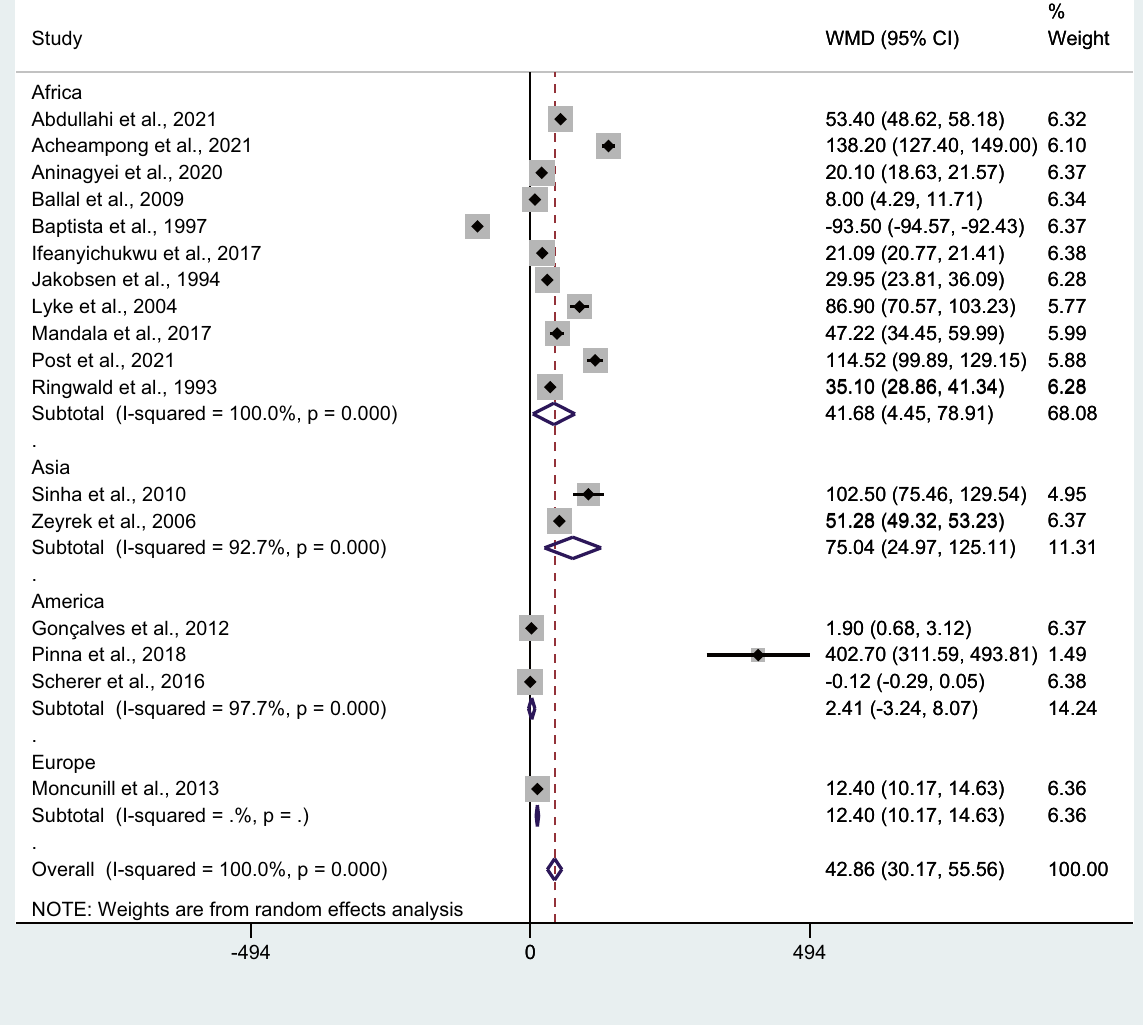
Figure 8. Differences in IL-6 levels between patients with uncomplicated malaria and controls by continents. Abbreviation: WMD, weighted mean difference; CI, confidence interval; black diamond symbol, point estimate; solid line in the middle of the graph at 0, zero effect size; Dashed red line: pooled WMD between the two groups; I 2 , level of heterogeneity; P = 0.000 or less than 0.05, significant